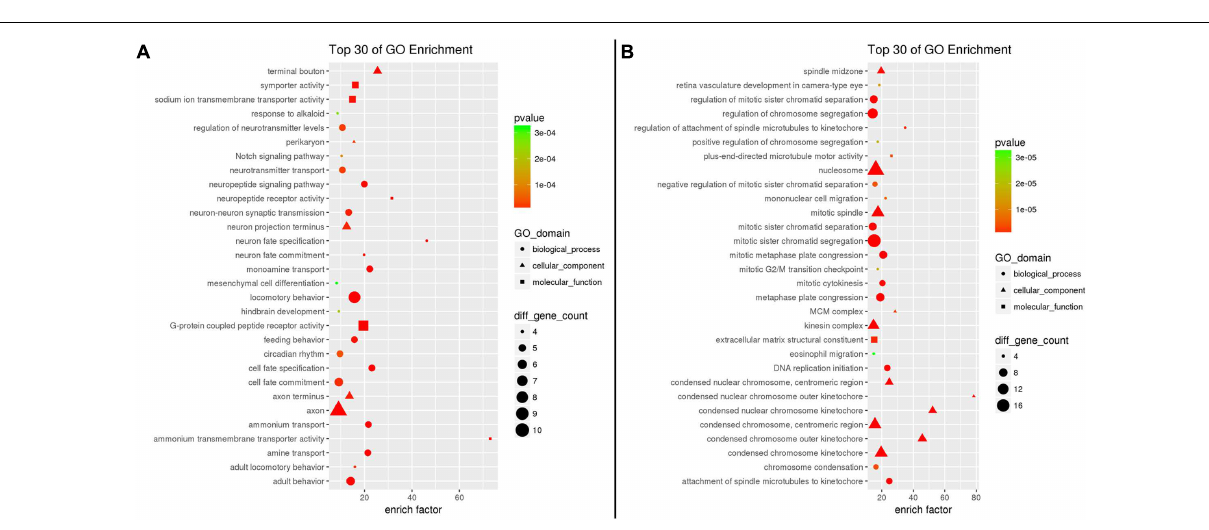
Frontiers in Pharmacology |